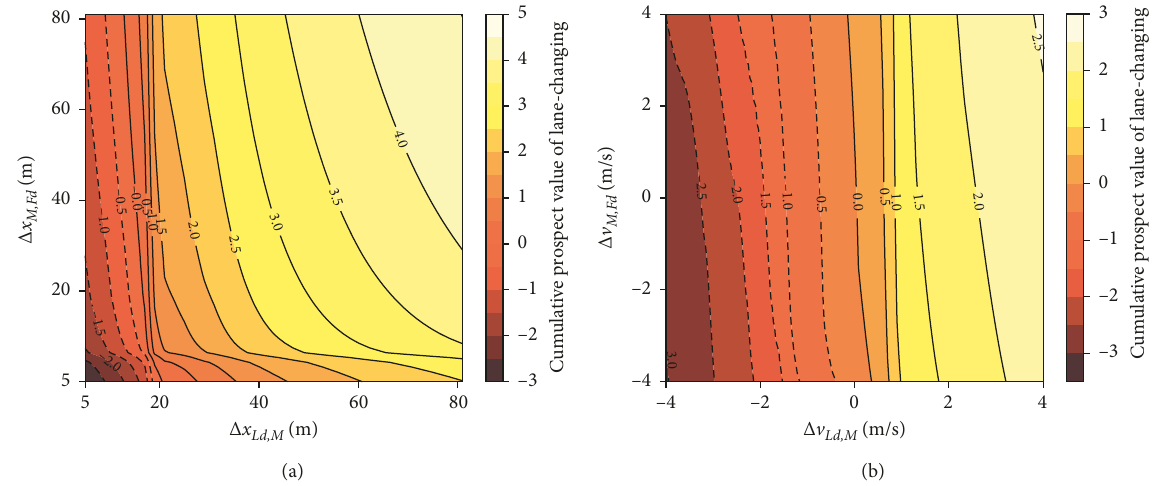
v x v Lo,M and Lo,M for M (cid:28) 10 m/s and (b) as Δ Δ